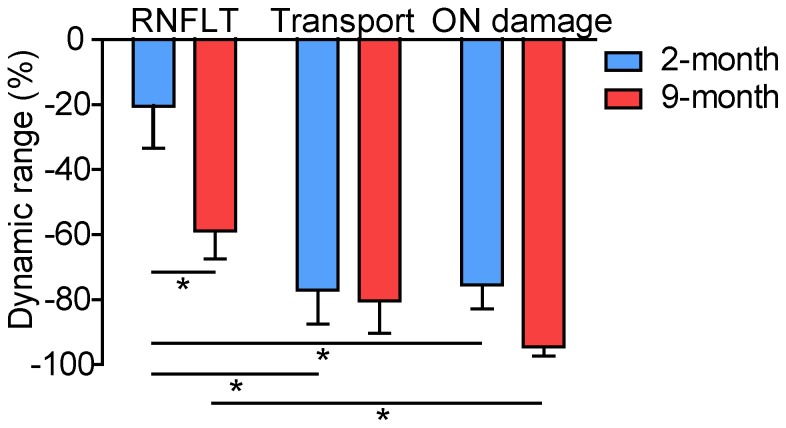
RNFLT, axonal transport and optic nerve damage relative to dynamic range after 3-weeks of unilateral IOP elevation.Loss of RNFLT was substantially less than axonal transport disruption and optic nerve damage and was greater in the younger rats despite a similar IOP insult in both age groups. Error bars  =  SEM. * indicates p<0.05 (Bonferroni post-hoc tests). Abbreviations: ON  =  optic nerve.